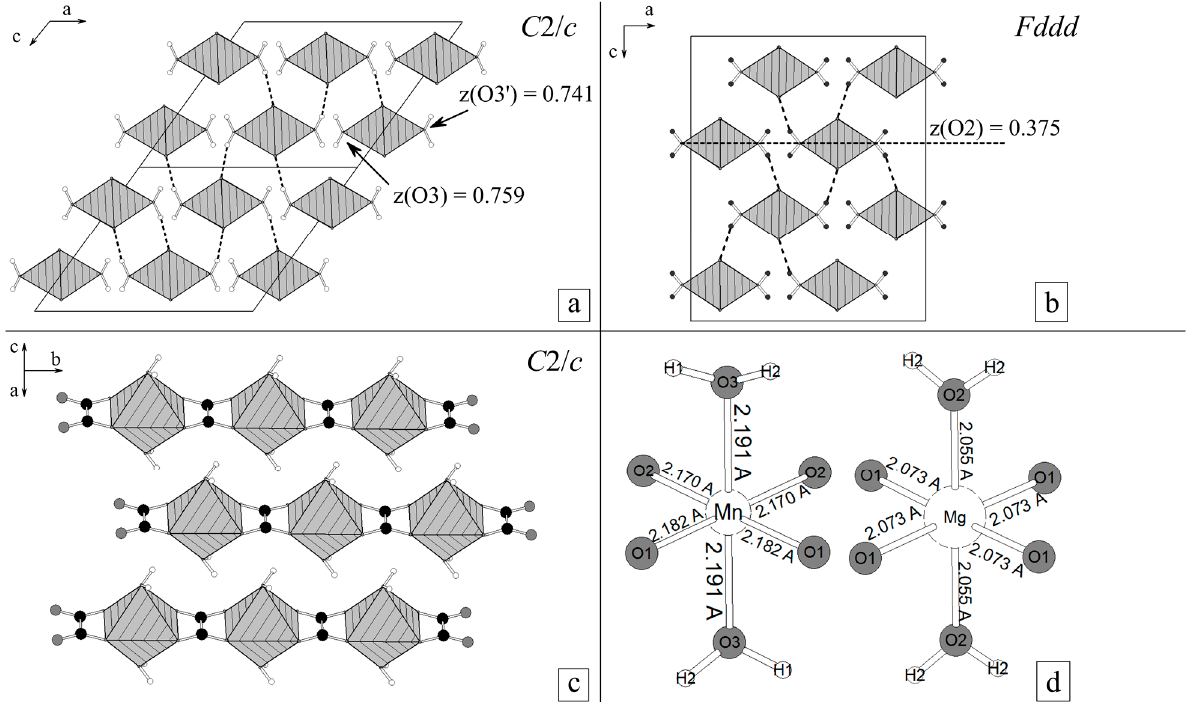
Figure 1. Crystal structures of Mn and Mg oxalate dihydrates: ( a )—chains of Me 2+ octahedra and oxalate ions along [010] (by example of α - MnC 2 O 4 ∙ 2H 2 O, [12]); ( b )—octahedra Me 2+ O 4 (H 2 O) 2 ; ( c )—projection of structure of α -MnC 2 O 4 ∙ 2H 2 O on ac plane; ( d )—projection of structure of β -MgC 2 O 4 ∙ 2H 2 O on ac plane ([10], a ↔ b). Notation: hatched octahedra— Me 2+ O 4 (H 2 O) 2 ; ● —carbon atoms; ○ —hydrogen atoms; black dashed lines—hydrogen bonds.